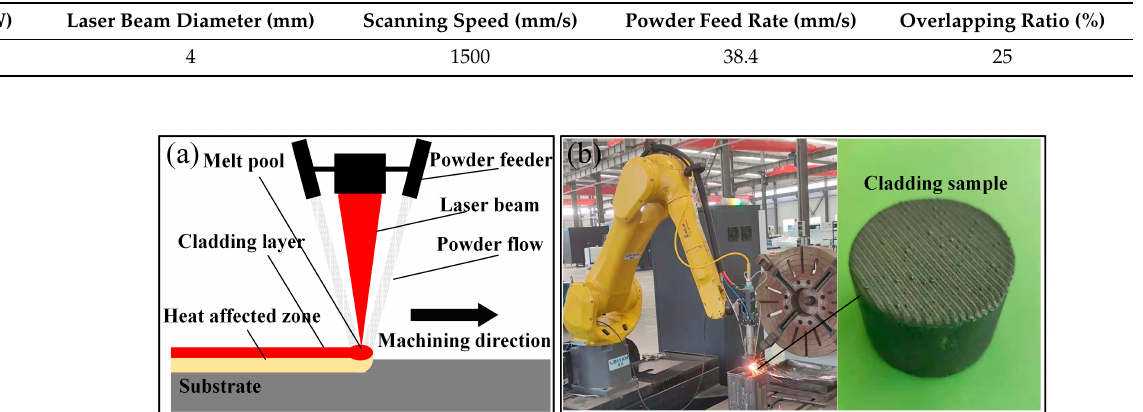
0.3 Figure 3. ( a ) Illustration of UB processing, ( b ) photos of the UB experiment setup. A total of five different samples were prepared for the experiment, as follows. The substrate sample was briefly described as HT(GCr15) as a control sample. Two coating samples, prepared by first laser cladding and then turning finely, were briefly described as LC(FeCoNiCr) and LC(CoCrNi). Furthermore, another two coating samples, prepared by laser cladding, turning finely, and UB treatment, in sequence, were briefly described as UB(FeCoNiCr) and UB(CoCrNi). All samples were cleaned in an ultrasonic cleaner for 10 min after being treated.